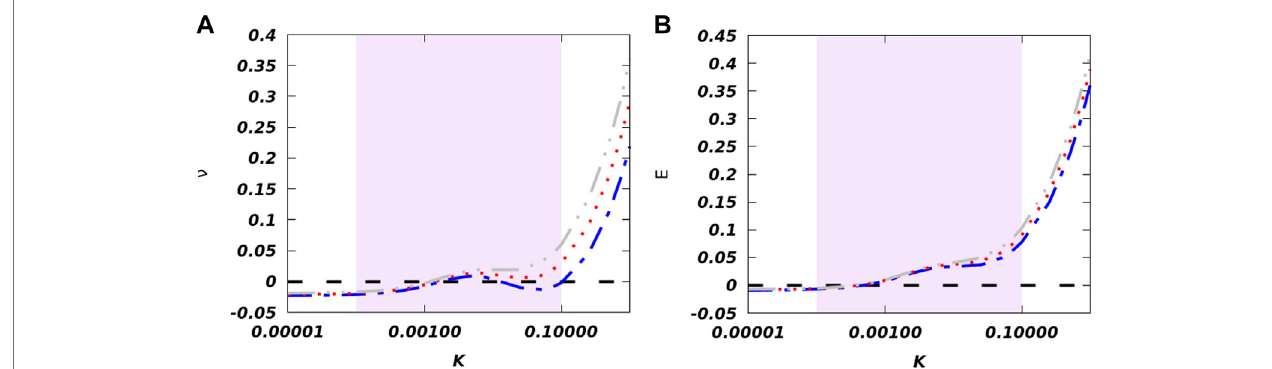
FIGURE 9 | (Color online) (A) The variation of chemical potential, while the trapping potential is tuned, is depicted here for different κ values. The grey dashed- double-dotted line corresponds to κ = 0.9, the red dotted and blue dashed-dotted lines describe the variation of chemical potential with trap frequency for κ = 0.5 and 0.1, respectively. The black dashed line indicates ] = 0. The shaded area describes the crossover regime. (B) Change in energy with variation in the trap frequency is plotted here for different BMF interaction strengths. The colors and line styles have the same meaning as previous. The black dashed line indicates E = 0. The light magenta area corresponds to the region of transition from droplet to